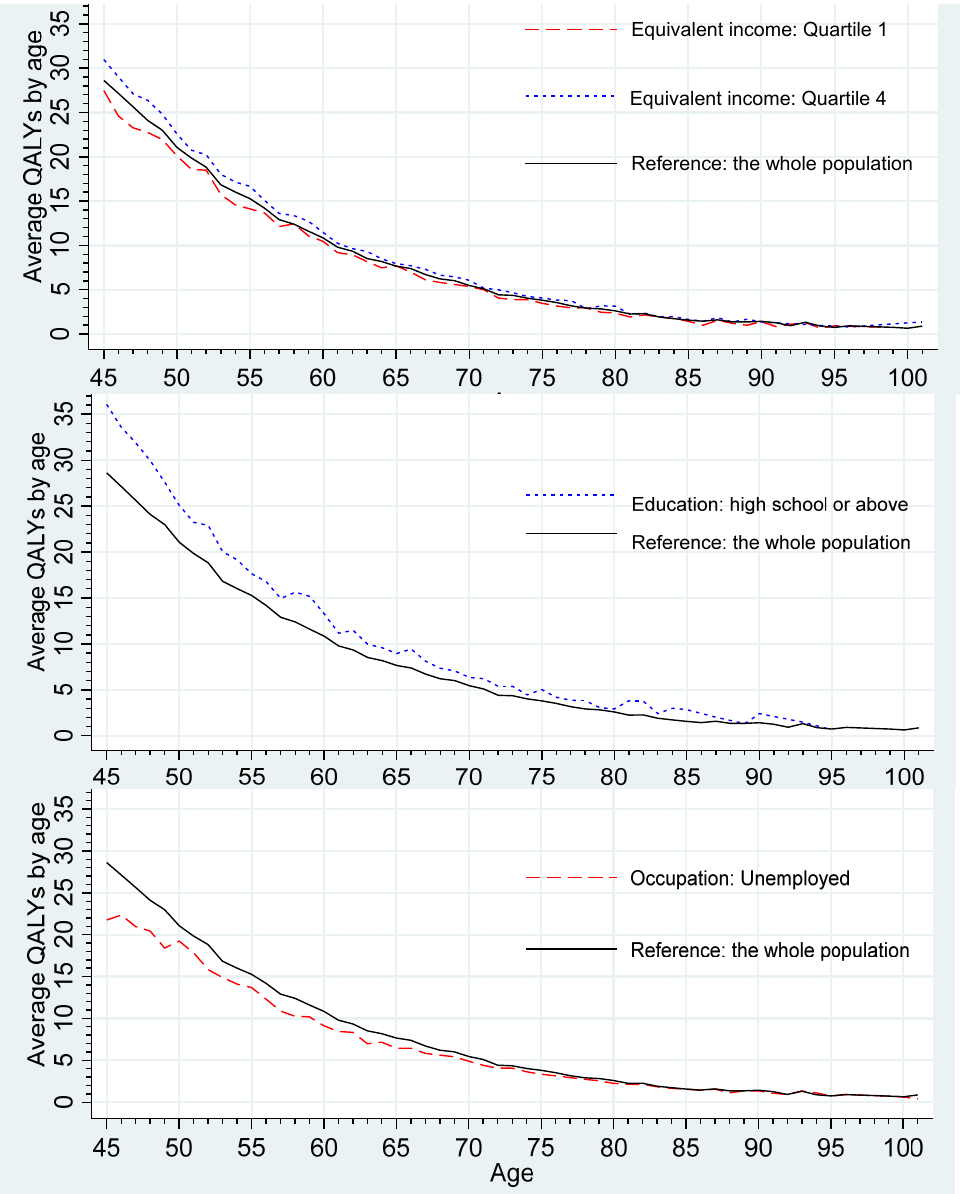
Figure 2. Average QALYs by age for the subgroups with varied socioeconomic statuses.